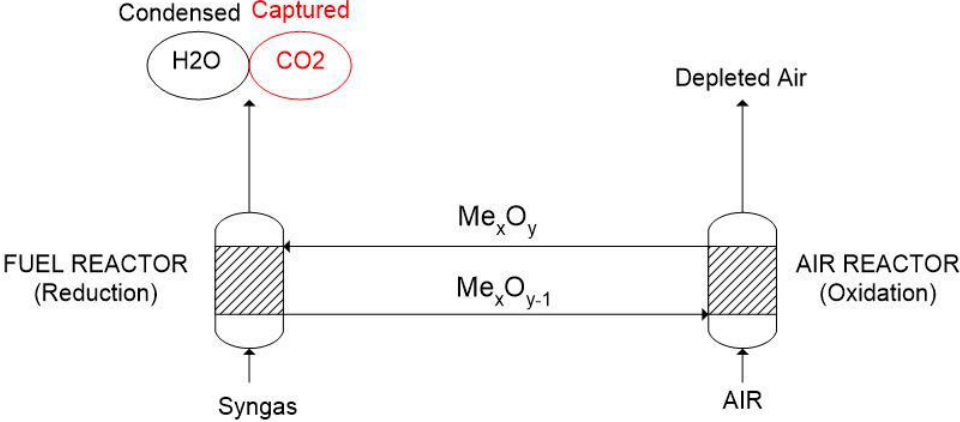
Figure 2. The GTCLC-NEG concept.